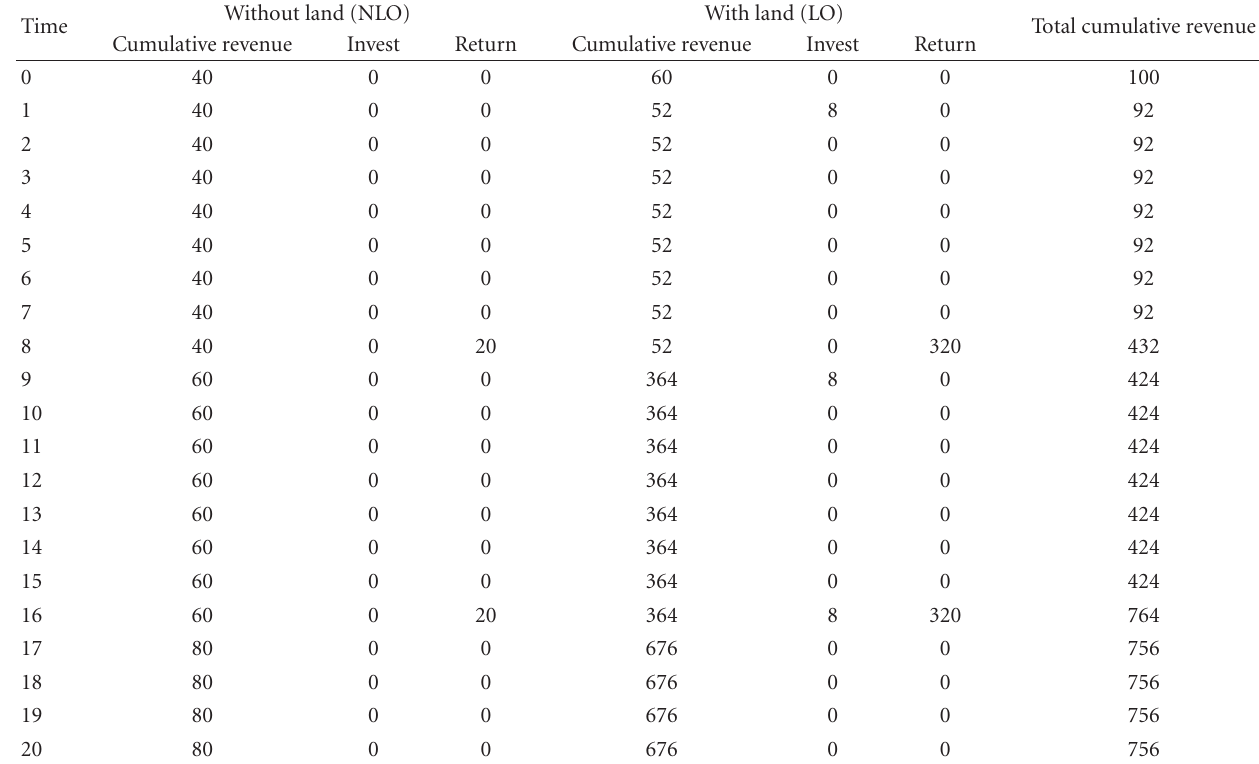
Table 2: The players’ cumulative revenue under scenario A (million rupiahs).